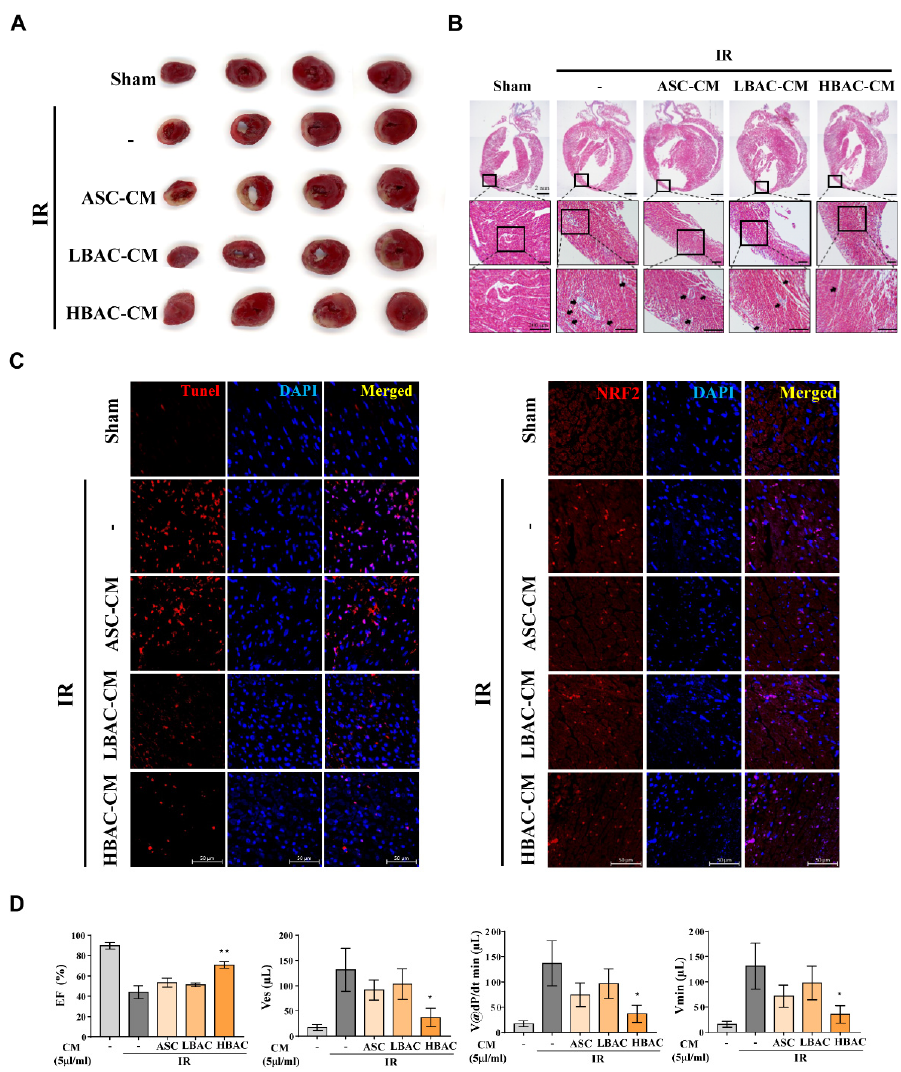
Figure 7. Effect of beige adipocyte secretions on IR rat hearts. ( A ) Triphenyl tetrazolium chloride (TTC) staining showing the infarct areas in transverse sections. Representative images of rat heart slices stained with TTC. ( B ) Histological analysis of IR rat hearts after beige adipocyte secretion injection. Cardiac fibrosis was evaluated by Masson’s trichrome staining. Scale bar = 2 mm (upper panel images), 200 μ m (down panel images). ( C ) Representative images of TUNEL staining and NRF2 immunofluorescence. Scale bar = 50 μ m. ( D ) Cardiac function was valuated with a Millar catheter in rat heart at three weeks after IR and treatment of CMs. EF, ejection fraction; ESV, end-